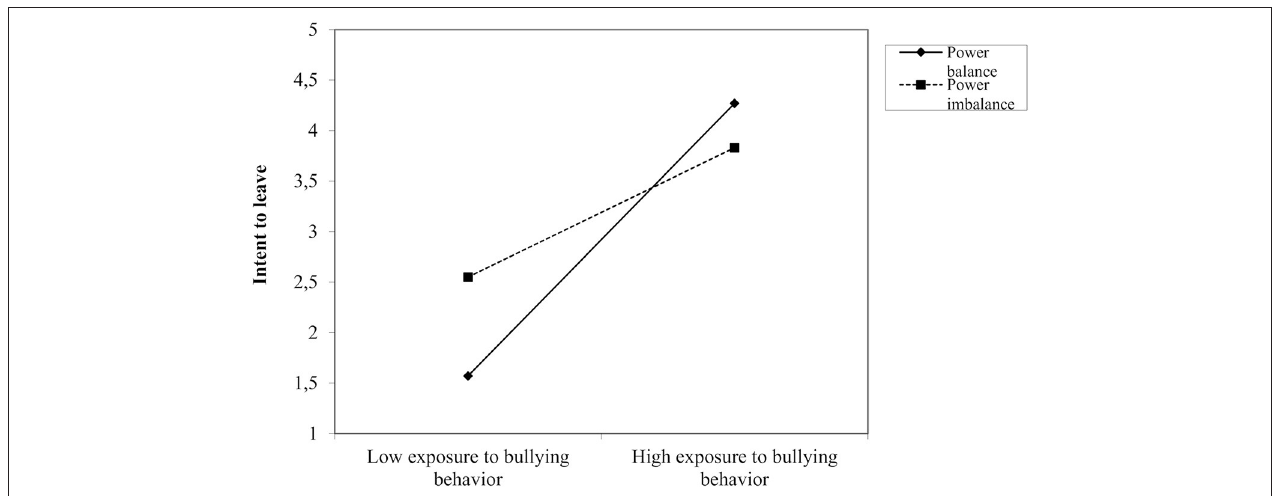
FIGURE 1 | Interaction between exposure to bullying behaviors and power relation regarding intentions to leave.